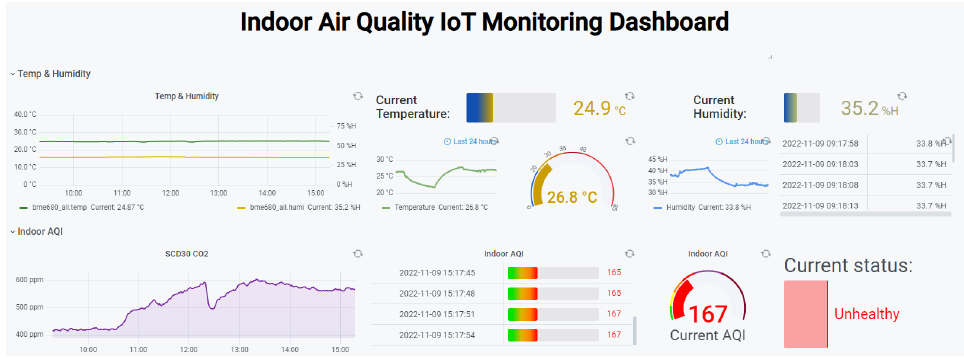
Figure 2. IAQ monitoring